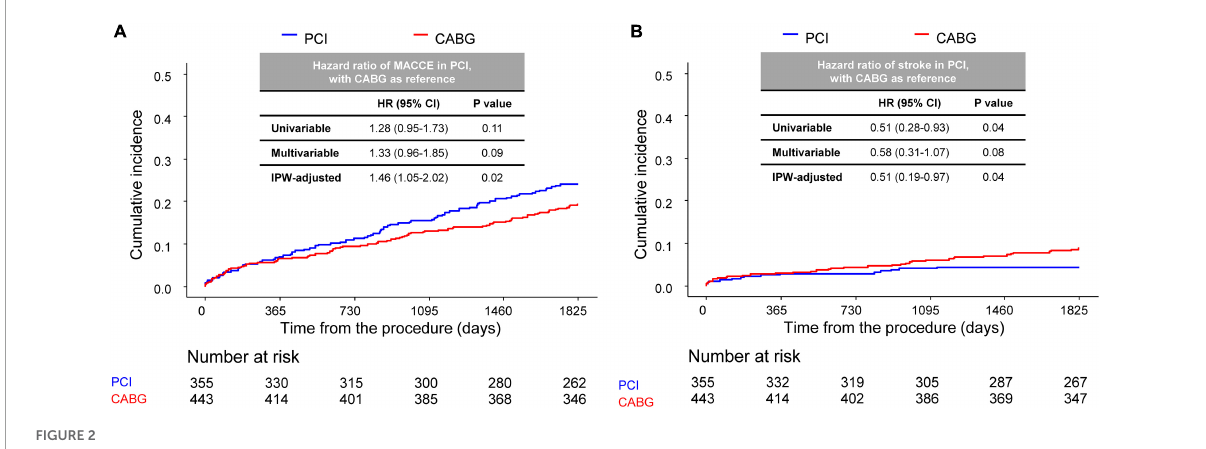
FIGURE2 Comparison of 5-year MACCE between CABG and PCI. Kaplan–Meier curve comparing (A) MACCE and (B) stroke at the 5-year point between the CABG and PCI groups. CABG, coronary artery bypass graft; PCI, percutaneous coronary intervention; MACCE, major adverse cardiac and cerebrovascular events.